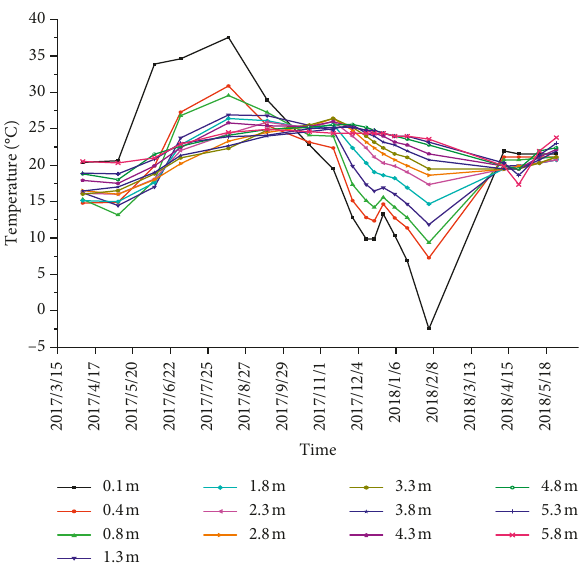
Figure 5: Variation in ground temperature with time.